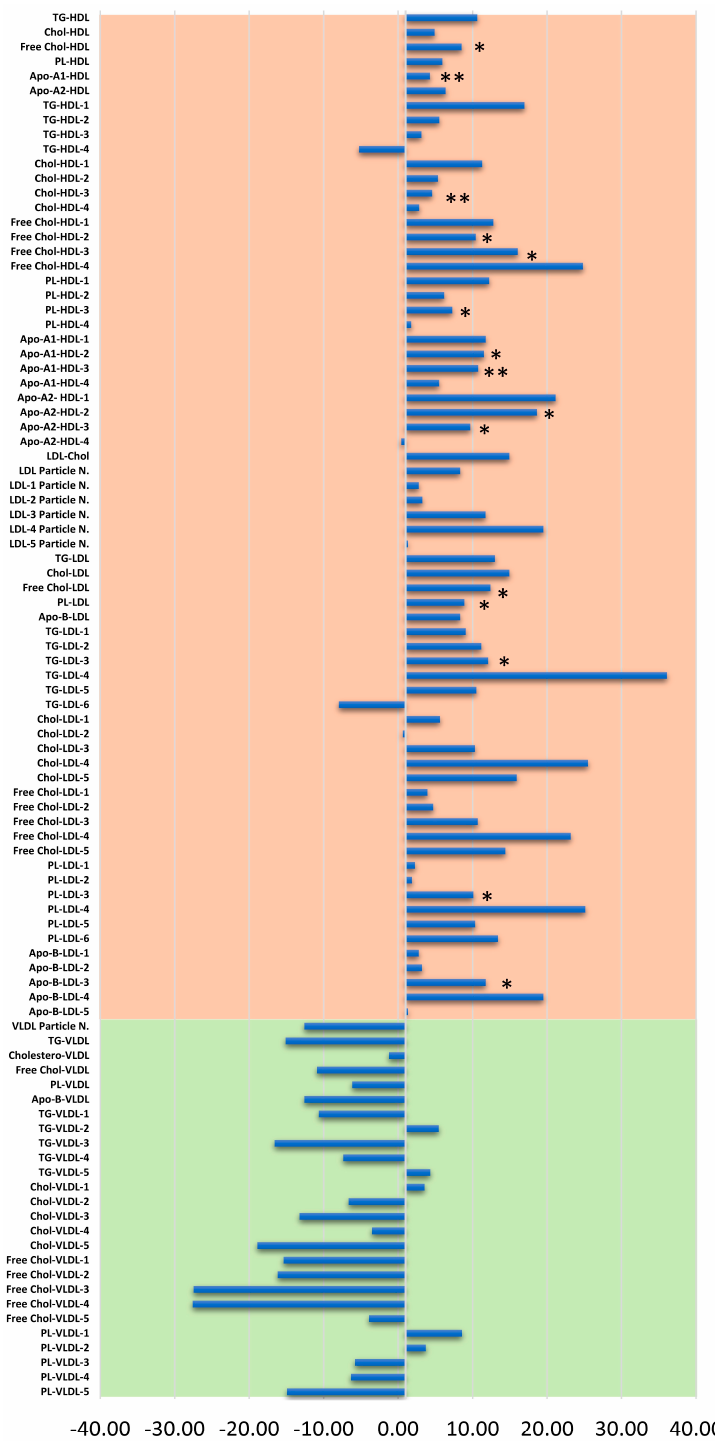
Figure 6. Changes in plasma lipoproteins concentrations after the two-year follow-up referred to baseline expressed as percentage relative differences. ** p < 0.01; * p <